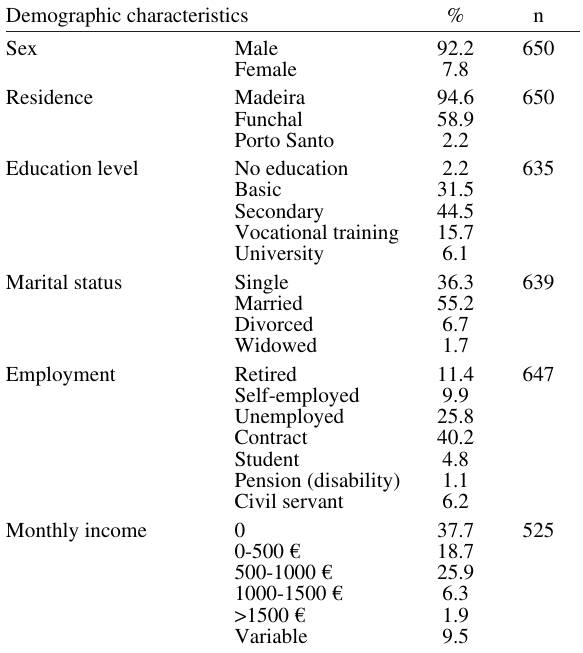
Table 2. – Recreational shore angling